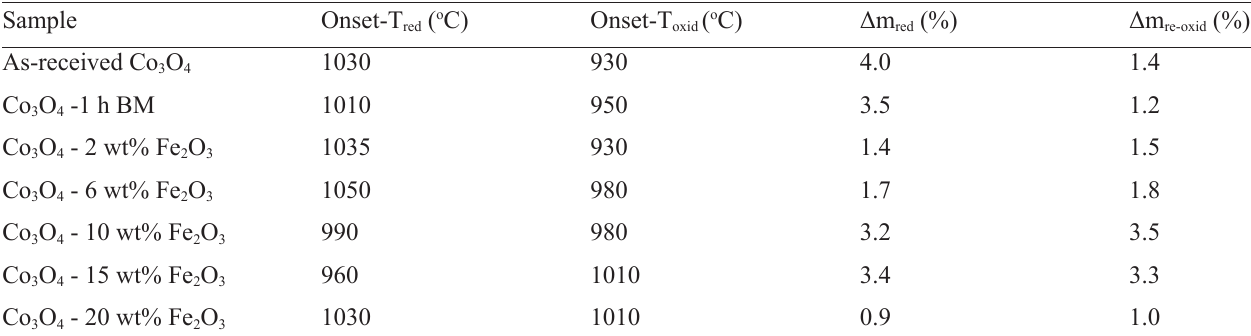
Table 2. Thermodynamic data obtained by thermogravimetry under air